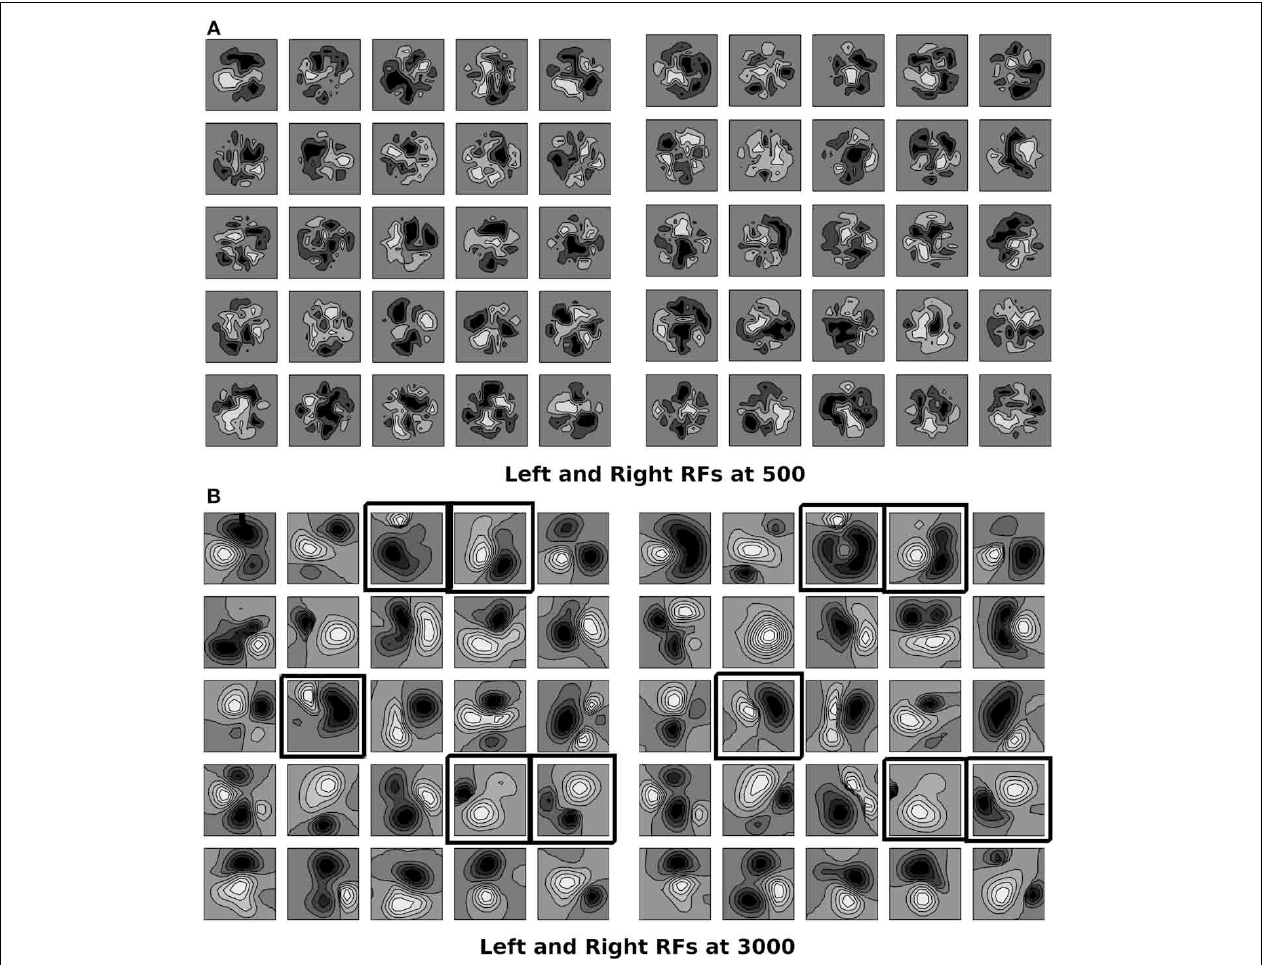
FIGURE 3 | (A,B) The left and the right RFs for a 5 × 5 section of cortex in the binocular zone are shown at 500 epochs, and 3000 epoch. RFs are locally diverse where near-by neurons have largely dissimilar receptive fields. The ON and OFF subregions are shown in Gray-scale with white (black) color representing connections from ON (OFF) LGN cells. The shading is proportional to strength of connection from LGN cells. At 500, epochs the sub-field structure is found only in few cells. The left and the